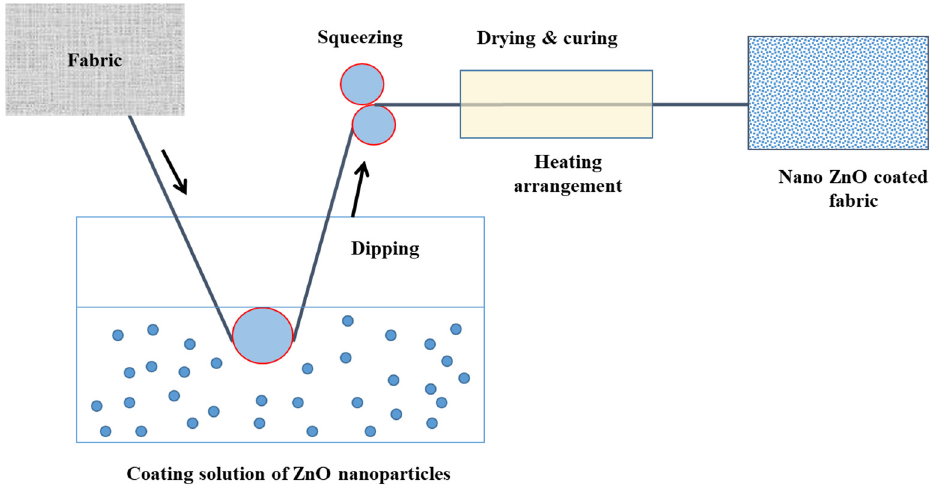
Figure 3. The sequence of thermo-fixation coating of nanoparticles on the fabric surface.